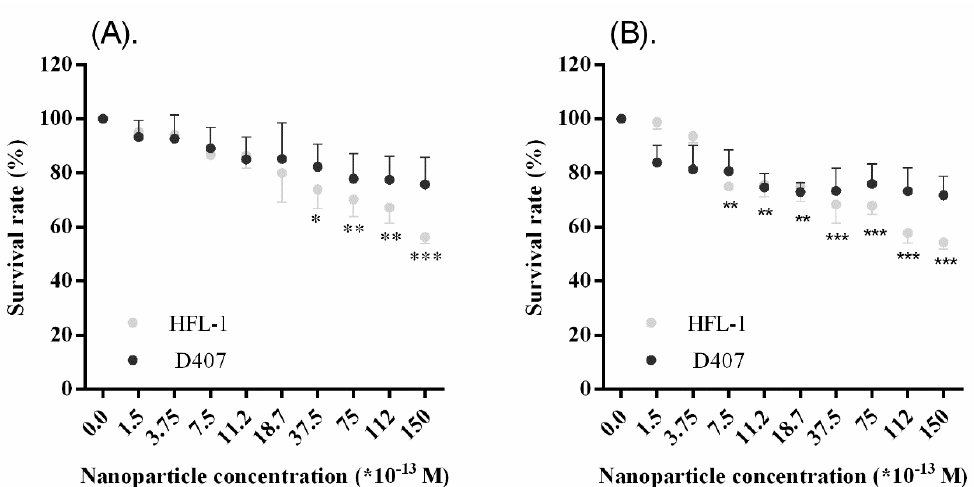
Figure 5. Cell viability assessed by MTT assay (mean ± SD; n = 3). The AuNPs’ effect on the survival rate of HFL-1 and D407 cells after 24 h ( A ) and 48 h ( B ) of treatment. Statistically significant differences: ( ∗ = significant, p -value range 0.01–0.05, ∗∗ = very significant, p -value range 0.001–0.01, and ∗∗∗ = extremely significant, p < 0.001).